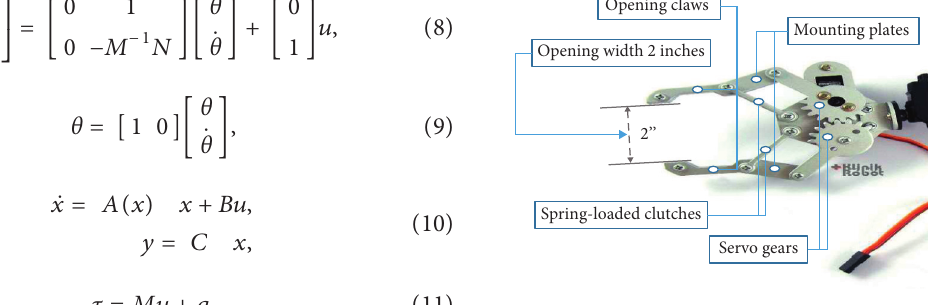
Figure 5: Gripper.